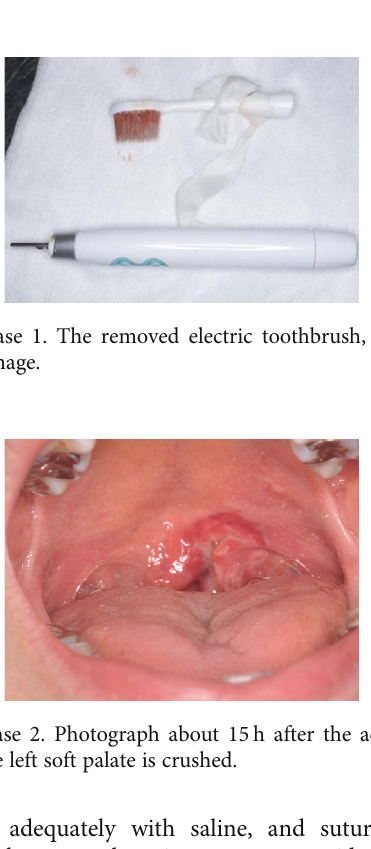
Figure 1: The two types of electric toothbrush. (a) Sonic toothbrush. (b) Oscillating-rotating toothbrush. (c) Electric toothbrushes and manual toothbrushes with scale.